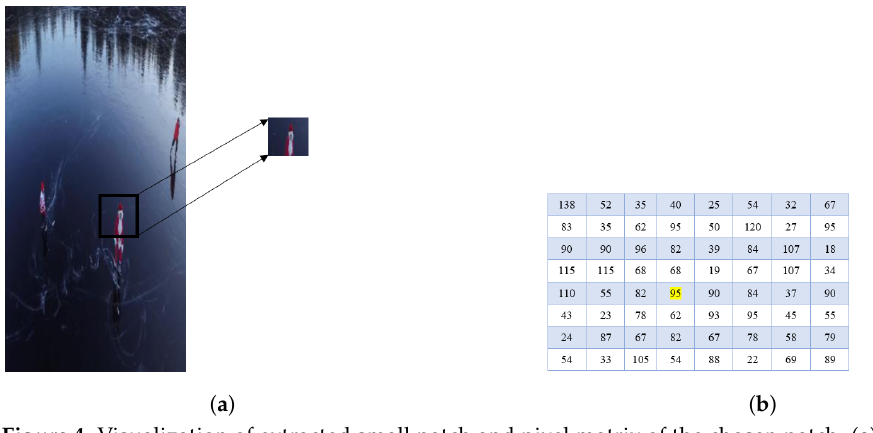
Figure 4. Visualization of extracted small patch and pixel matrix of the chosen patch. ( a ) Abstract a small patch. ( b ) Pixel matrix.